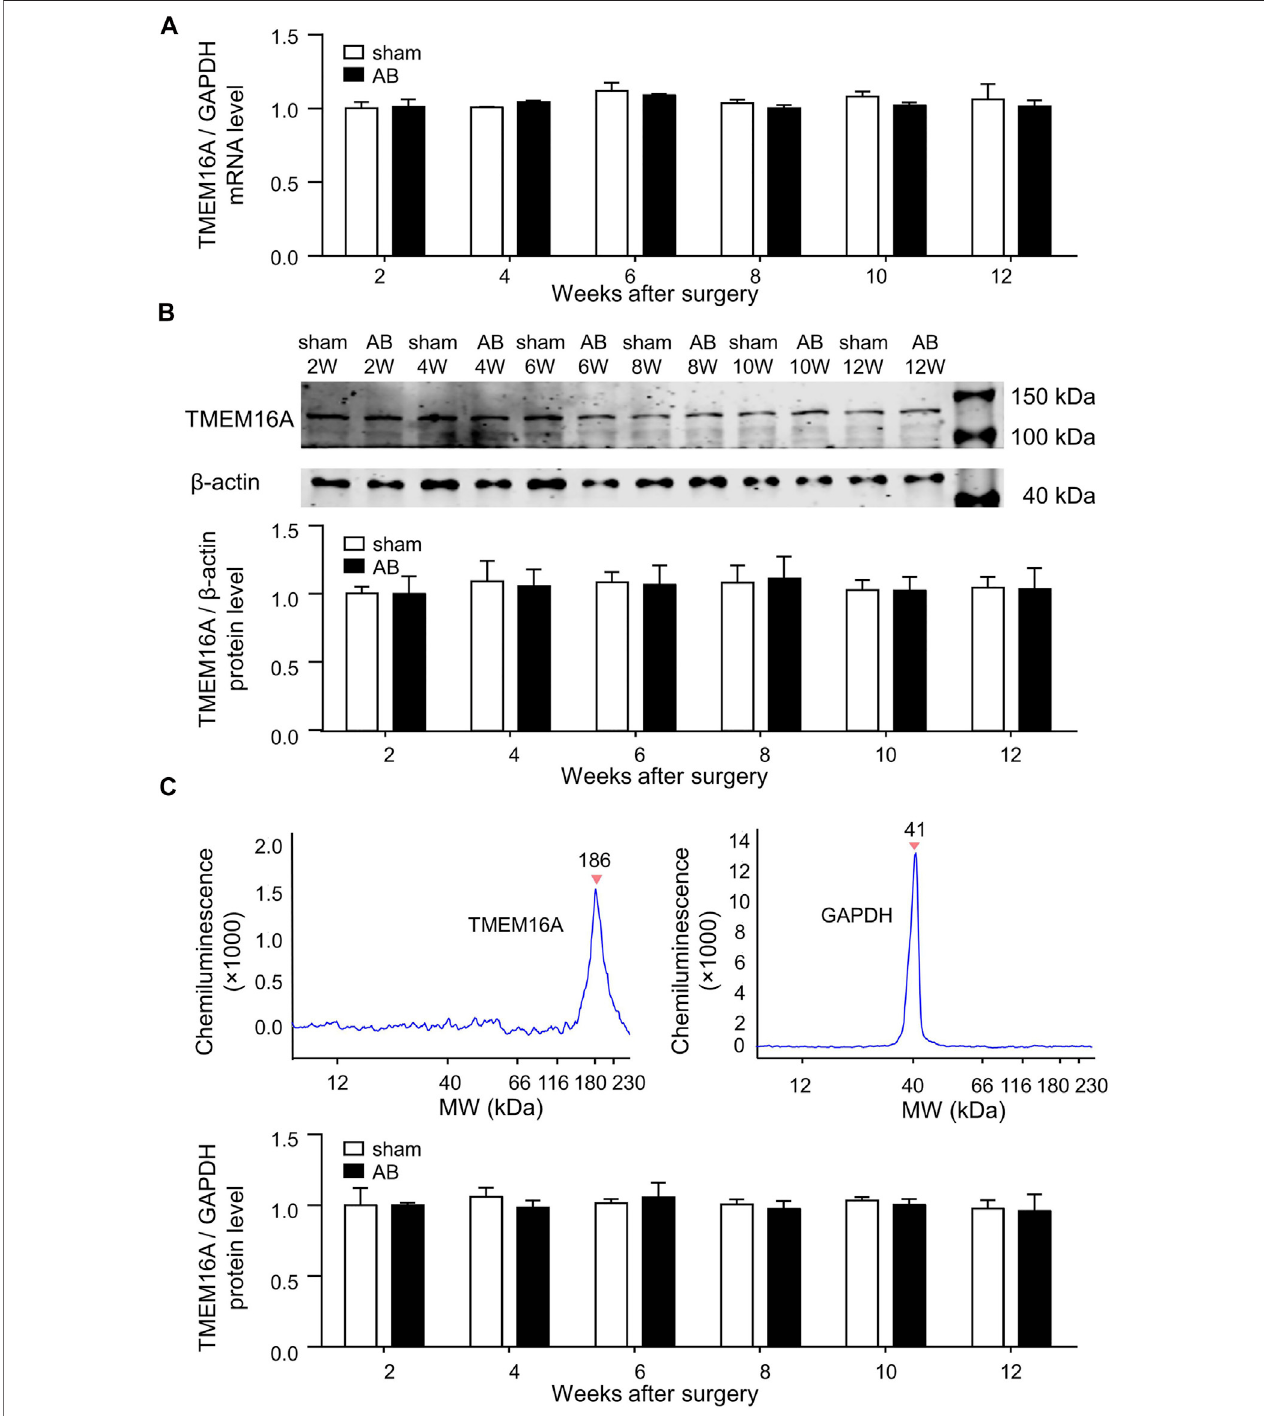
FIGURE 1 | Molecular expression levels of TMEM16A in LV. (A) TMEM16A mRNA expression level in LV ( n = 3 mice in each group per time point, RM two-way ANOVA). (B) Traditional western blot results of TMEM16A protein expression level in LV ( n = 3 mice in each group per time point, RM two-way ANOVA). (C) Simple western blot results of TMEM16A protein expression level in LV ( n = 3 mice in each group per time point, RM two-way ANOVA).